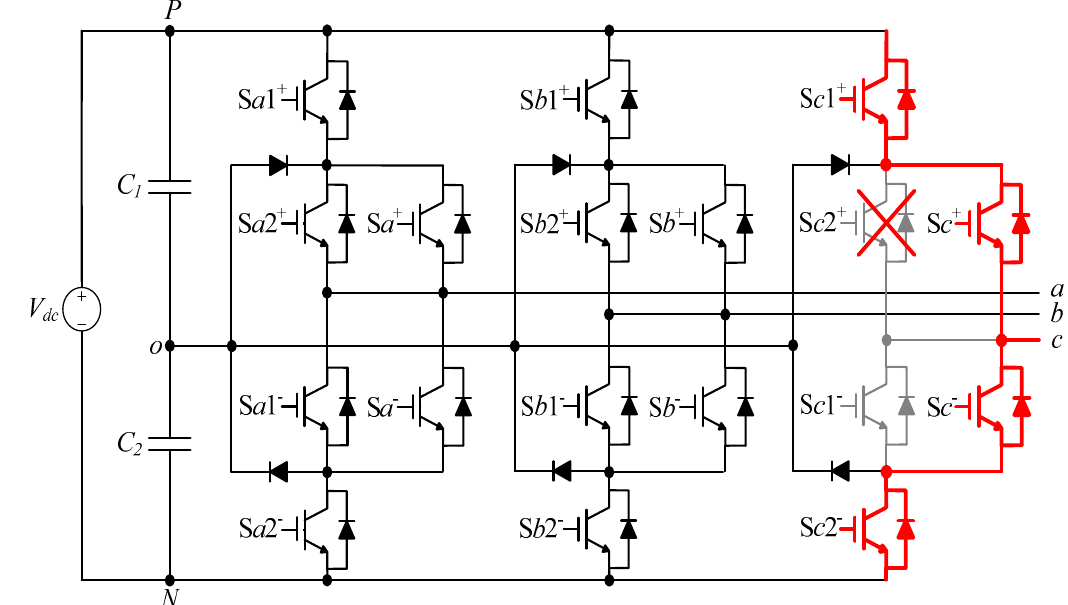
Figure 14. Framework of three-level NPC inverter with additional tolerant control switches.